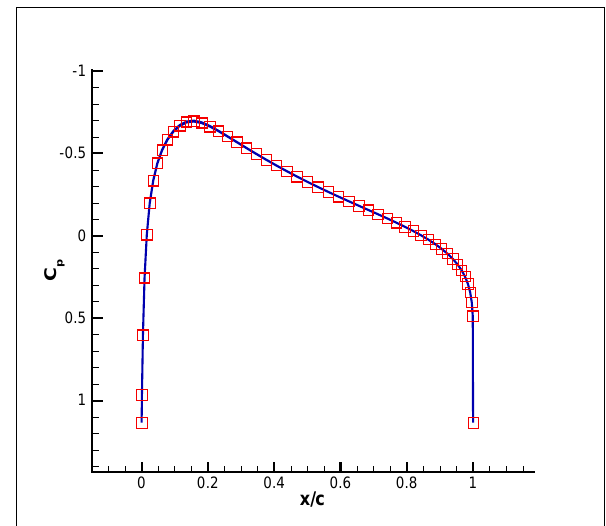
Figure 10. The pressure coe ffi cient distribution for NACA0012 using FOILcom ( M ∞ = M critical = 0.722, α = 0).